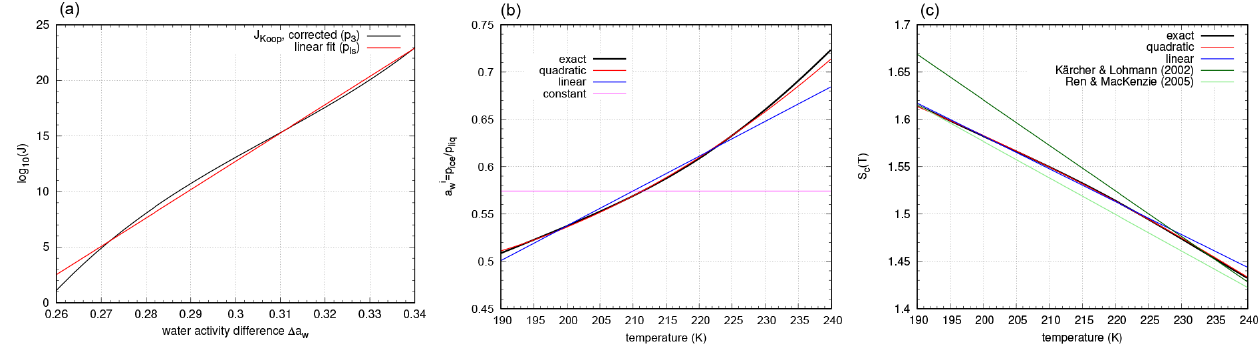
Figure 2. Polynomial approximations of the nucleation rate (a) , the ice water activity a i w ( T ) = p ice ( T ) S c ( T ) (c) , respectively. Panel (b) also includes the approximations by Kärcher and Lohmann (2002) and Ren and Mackenzie